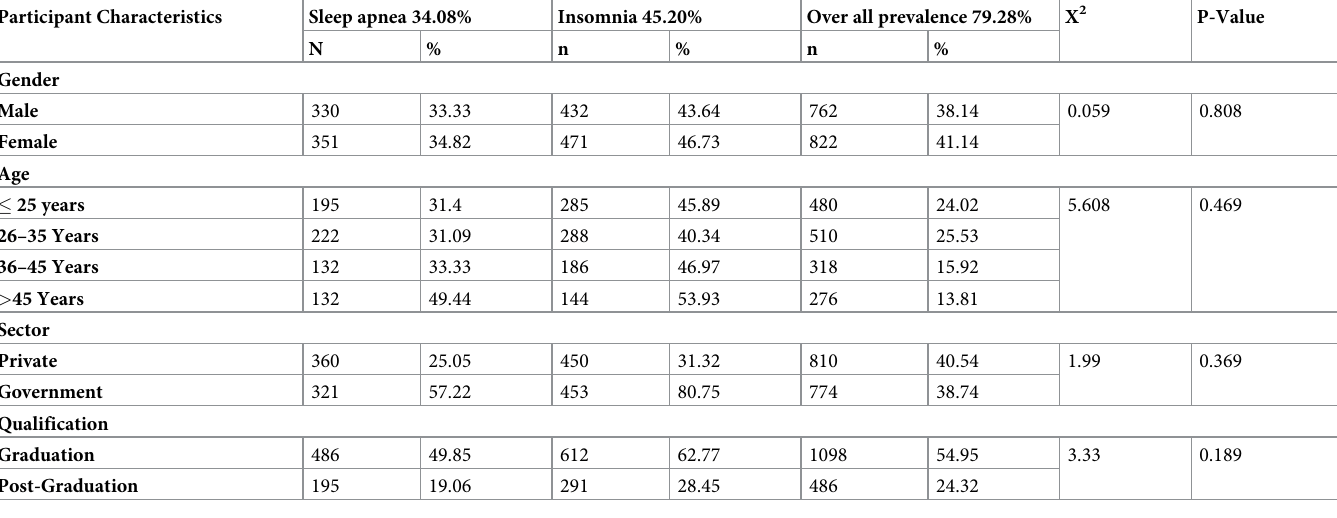
Table 3. Prevalence of sleep